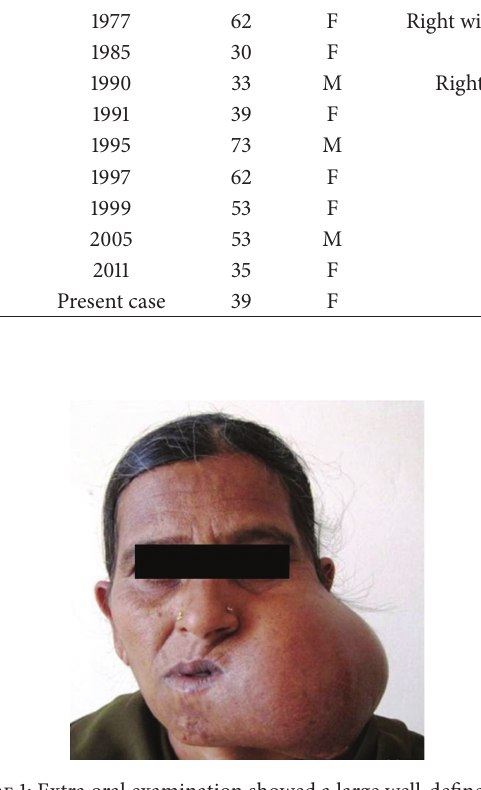
Figure 1: Extra oral examination showed a large well-defined swel- ling measuring approximately 12×9×10 cm in the left cheek, man- dible and submental region.